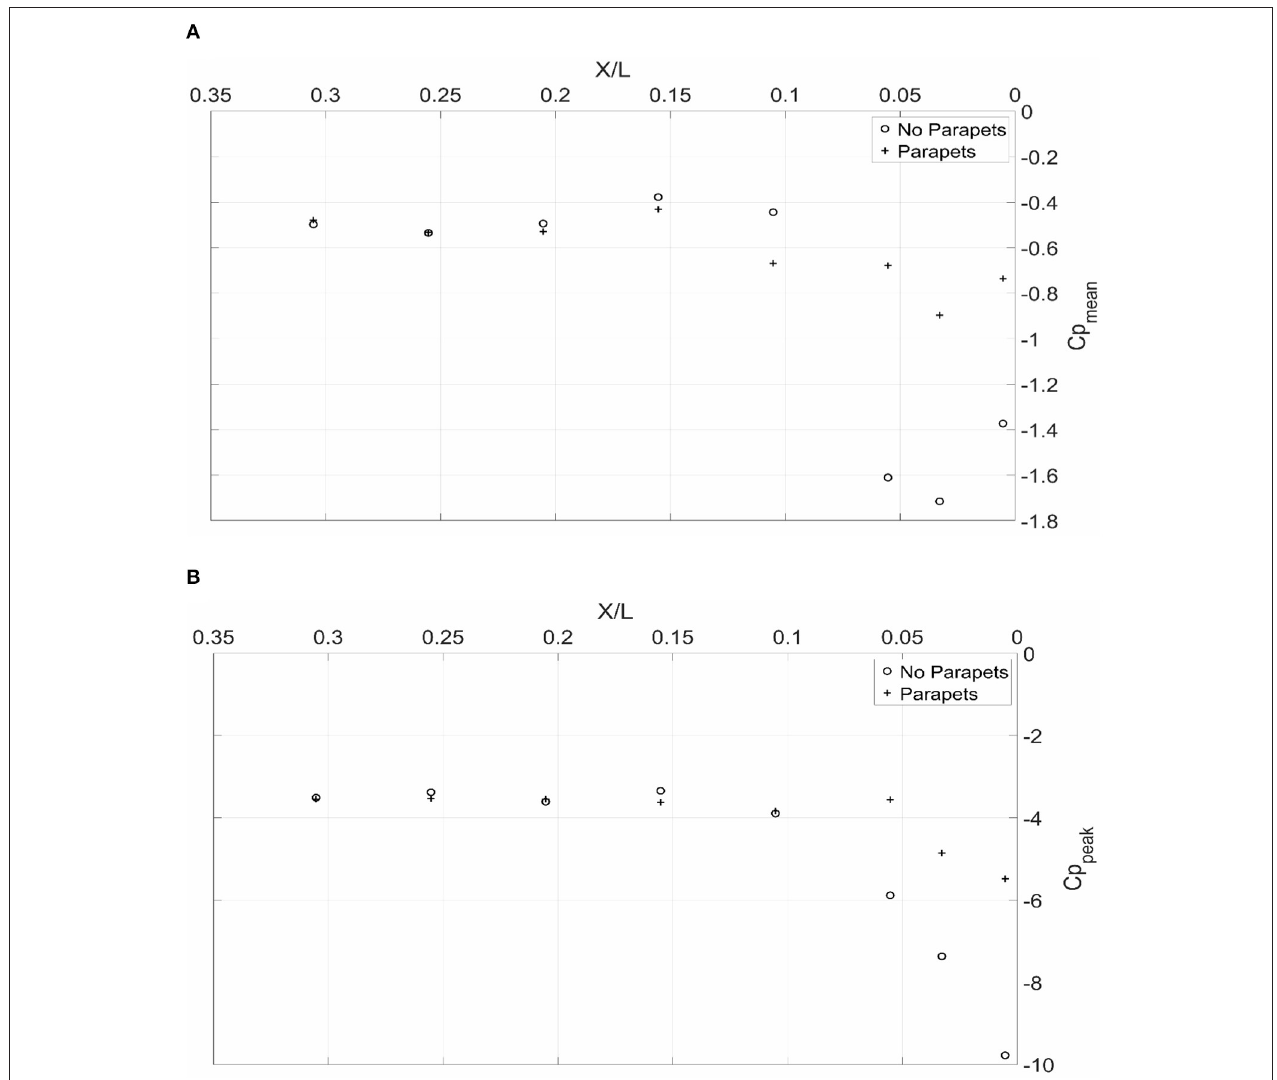
FIGURE 9 | Variation of: (A) Cp mean along the ridge at 45 ◦ wind direction, and (B) Cp peak along the eave end.